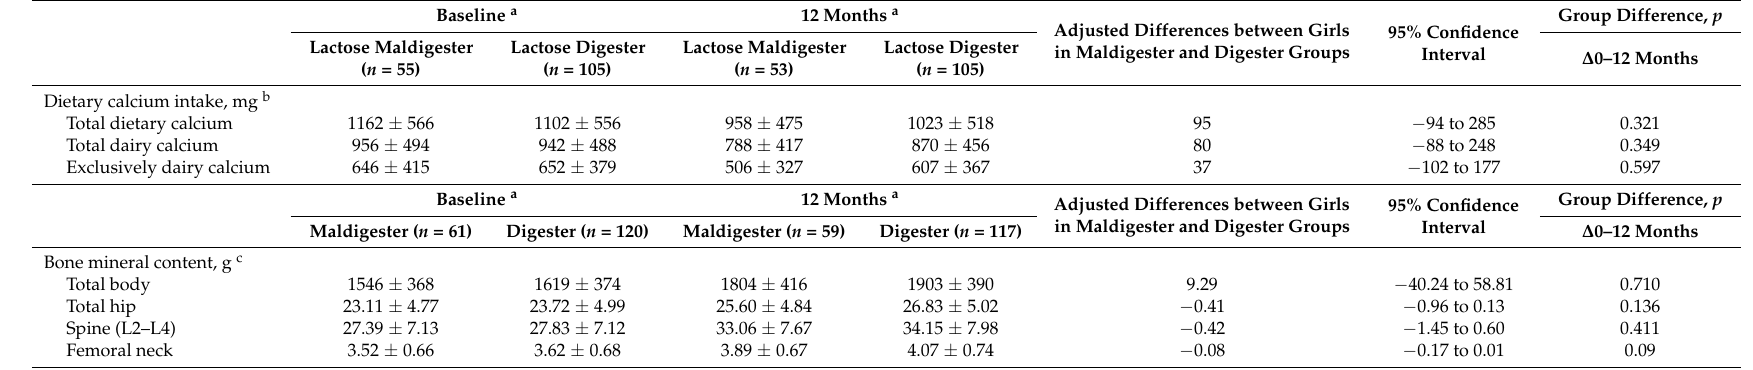
Table A1. Calcium intake and bone mass among early adolescent girls in the control group based on lactose digestion status at baseline and change at first follow-up visit at 12